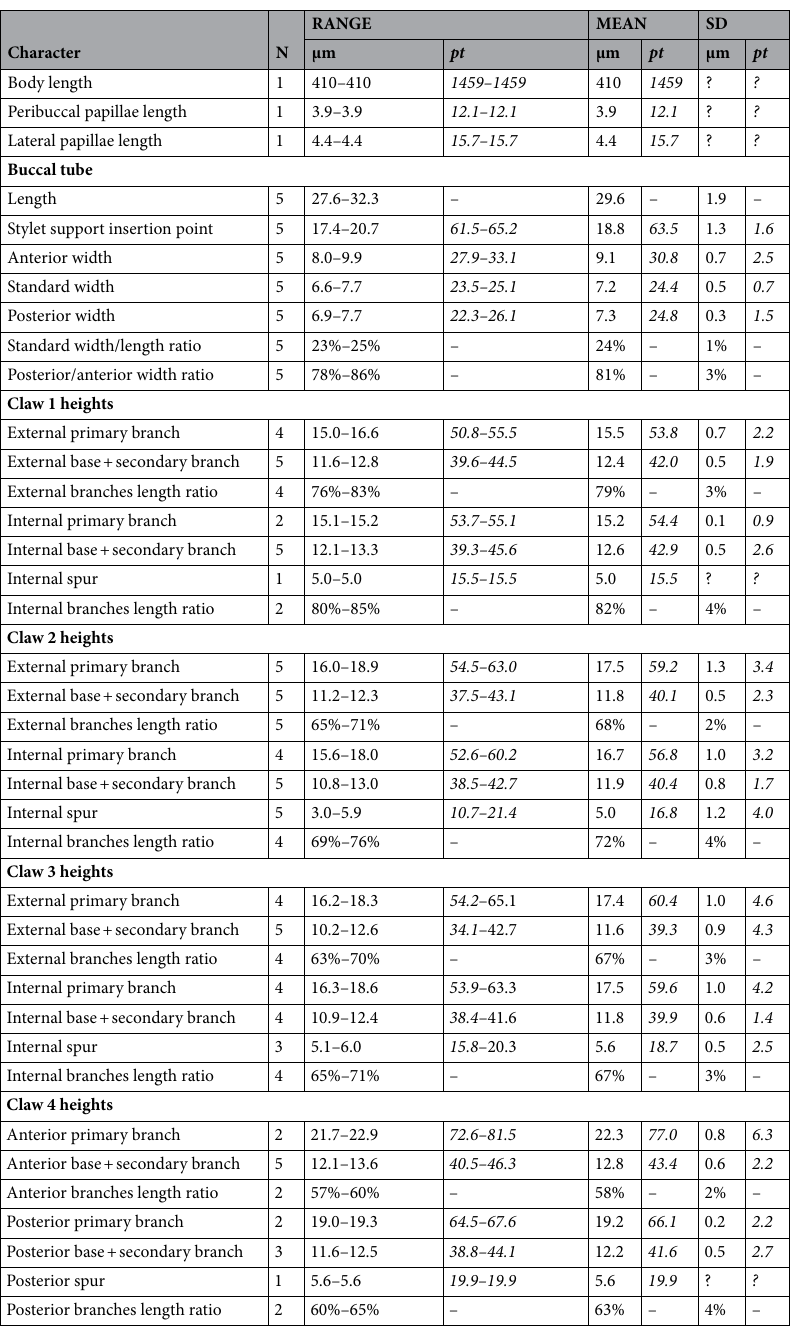
Table 4. Measurements (in μm) and the pt values of selected morphological structures of 5 males of Milnesium decorum sp. nov. from Portugal, PT.010, mounted in Hoyer’s medium. All available specimens were